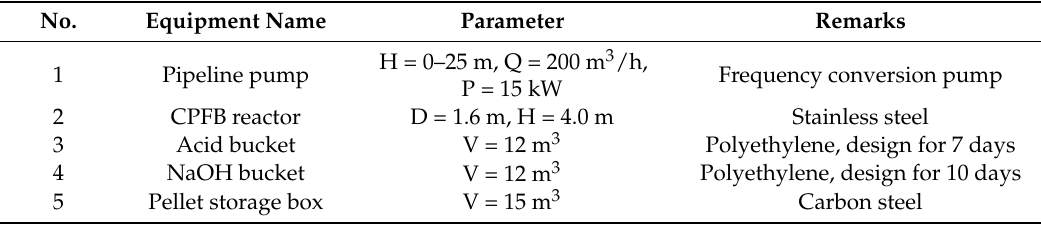
Table 2. Equipment parameters. CPFB: circulating pellet fluidized bed.